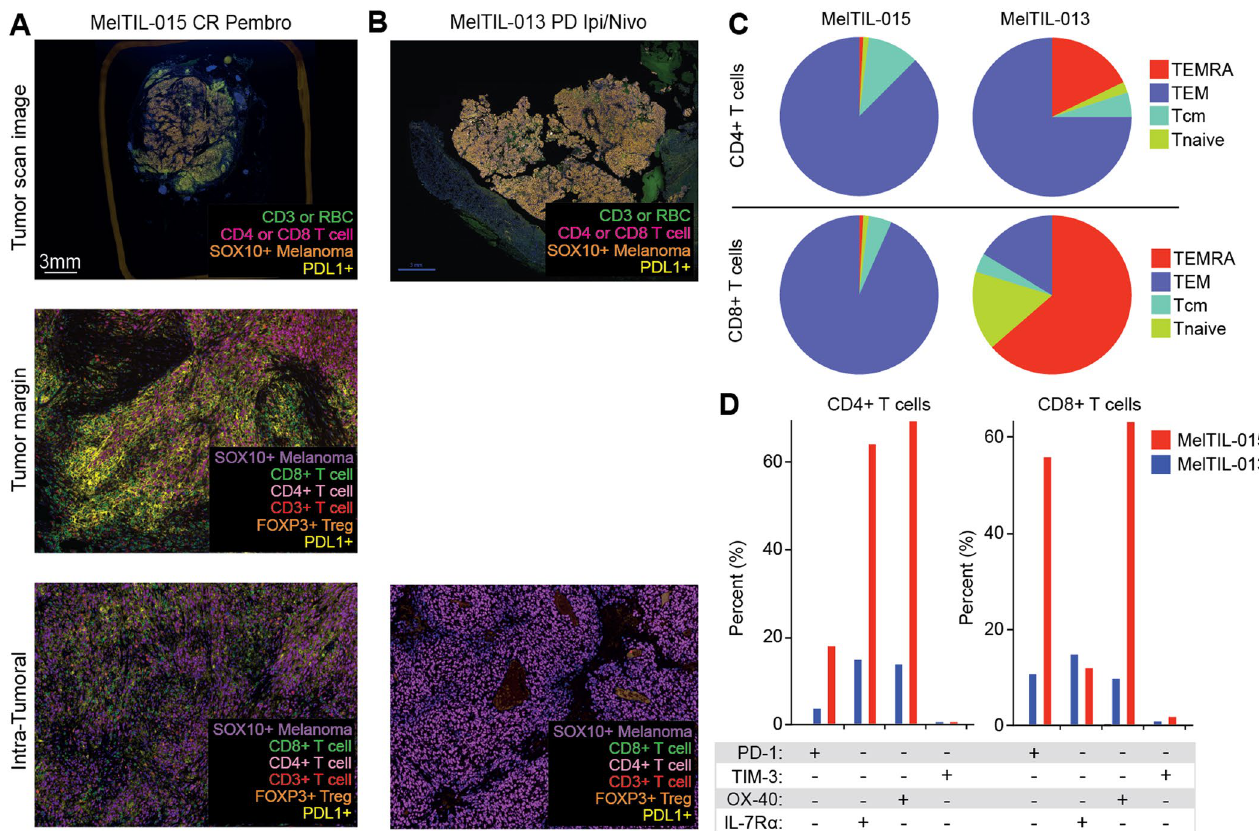
Figure 7. Using metastatic melanoma immune context data to understand checkpoint blockade inhibitor responses. Two metastatic melanoma samples (MelTIL015 and MelTIL013) had divergent responses to CBI. The immune context of each melanoma biopsy was examined by multiplex IHC ( A , B ) and FACS ( C , D ). Multiplex IHC data is shown for the T cell panel for MelTIL015 ( A ) and MelTIL013 ( B ) including a scanned low power image of the whole biopsy, plus an image at the TM or IT. FACS data was analyzed (as per Supplementary Fig. 6) and T cell differentiation compartments represented in pie chart format for MelTIL015 and MelTIL013 ( C ). In addition, TIL immune checkpoint (PD-1 and TIM-3), activation markers (OX-40) and IL-7R α expression were represented in column charts for MelTIL015 and MelTIL013 ( D